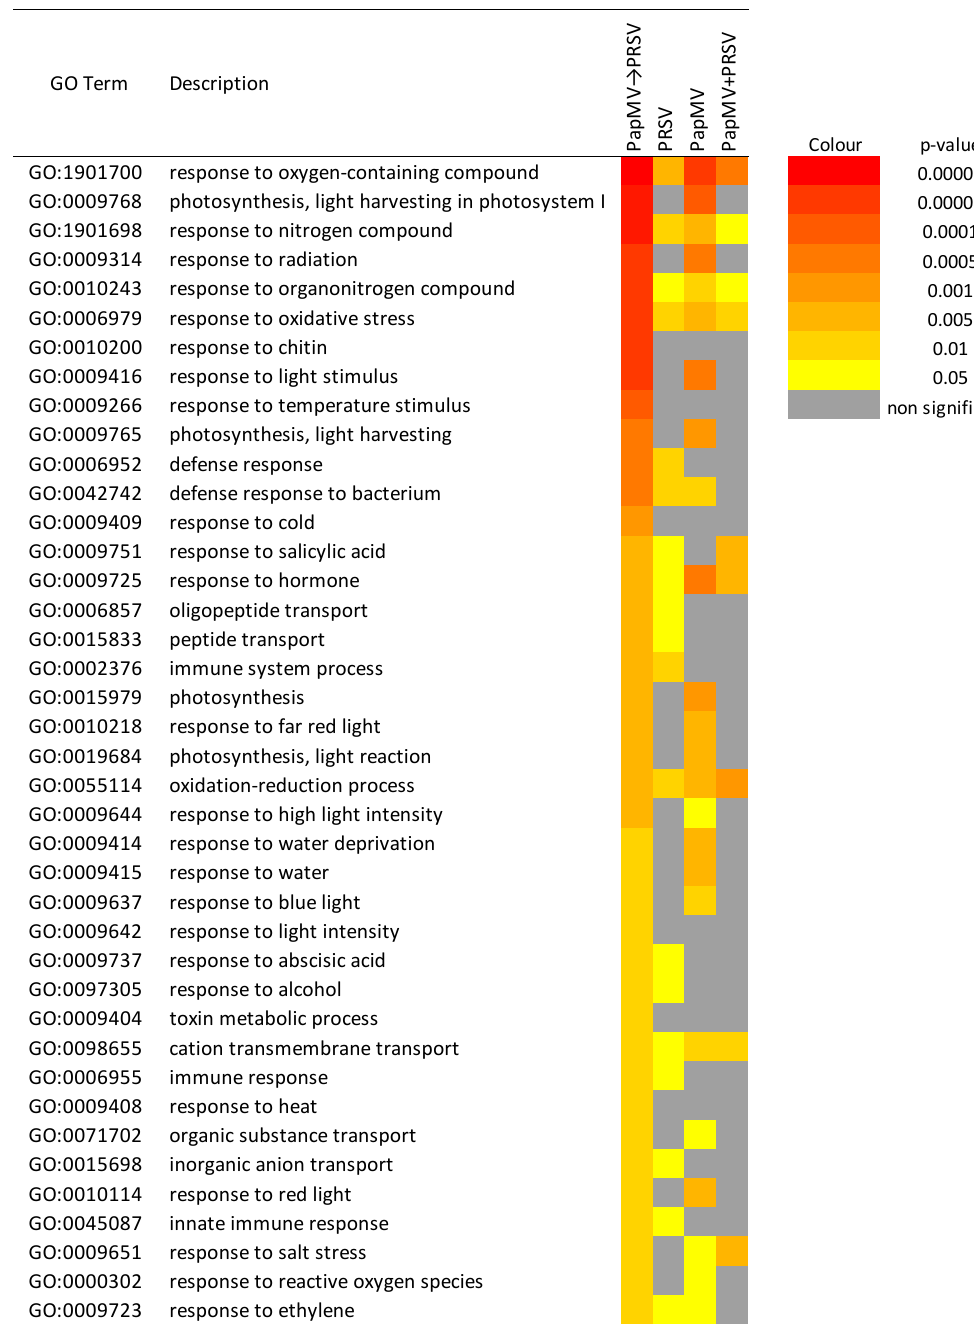
Figure 4. Color map of the cross-comparison of single enrichment analysis (SEACOMPARE). Color scale represents the significance level of ontology (BPs), for each condition. The figure only depicts those Gene Ontology (GO) terms that met the criteria of low redundancy OR present in the network unique for antagonism (PapMV → PRSV) OR shared with other conditions AND significant for PapMV → PRSV.